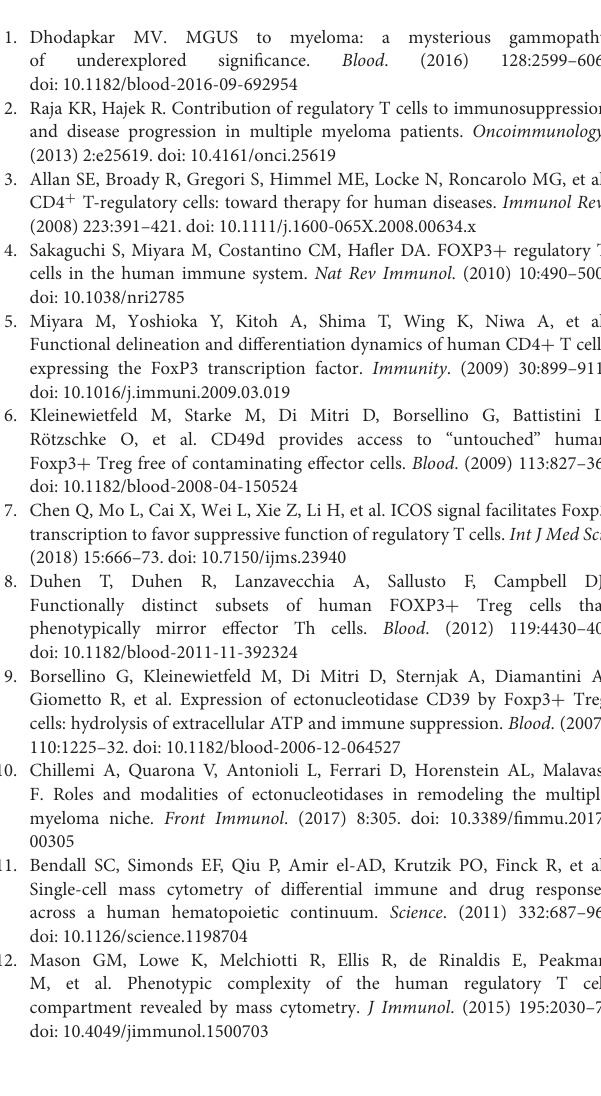
Figure S1 | Treg detection by flow cytometry and mass cytometry in the BM and PB of MGUS and NDMM patients. (A,B) Treg detection by flow cytometry: (A) Representative biaxial plot of Treg defined as FoxP3 + events. Numbers indicate percentage of FoxP3 + Treg. Representative histograms of the FoxP3 intensity in the Treg compartment in matched BM and PB of MGUS ( n = 2) and NDMM ( n = 3) patients. (B) Representative biaxial plot of Treg defined as CD25 + CD127 low / neg . Numbers indicate percentage of CD25 + CD127 low / neg Treg. Frequency of CD73 + Treg within the Treg compartment in BM and PB of MGUS (BM = 5, PB = 6) and NDMM (BM = 12, PB = 13) patients. (C) Representative biaxial plot of Treg defined as CD25 + CD127 low / neg by mass cytometry. Numbers indicate percentage of CD25 + CD127 low / neg Treg. Frequency of Treg in BM and PB of MGUS ( n = 4) and NDMM ( n = 8) patients. Box and whisker plots show min and max, with median and individual data points.